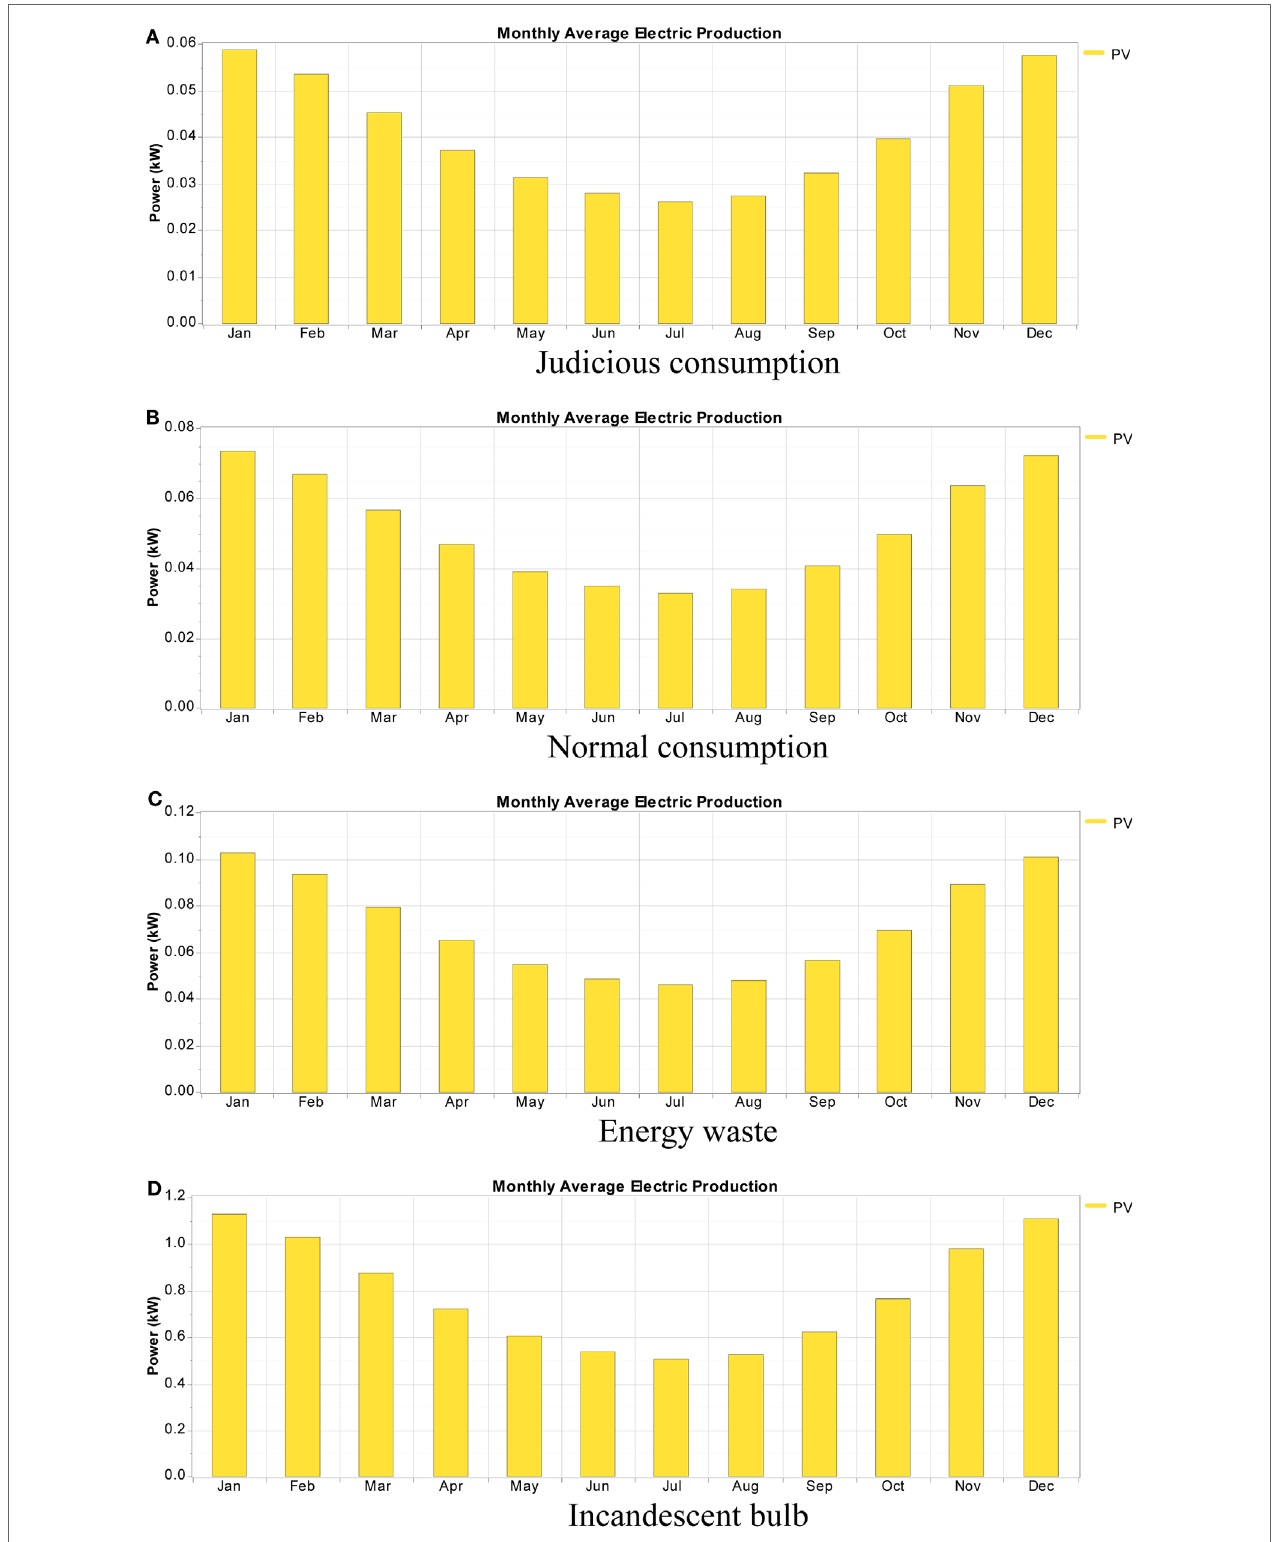
FigUre 8 | electrical production of PV energy system for (a) judicious consumption, (B) normal consumption, (c) energy waste, and (D) incandescent bulb